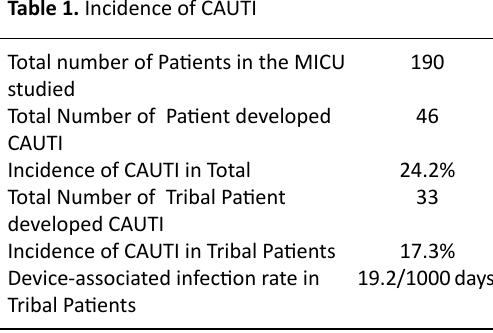
Table 1. Incidence of CAUTI Total number of Patients in the MICU Total Number of Patient developed